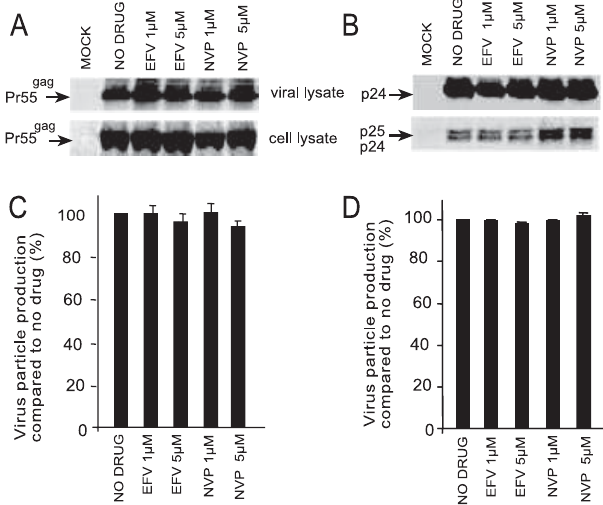
Figure 7. Inhibition of Viral Particle Production by EFV Is Dependent on a Functional HIV-1 PR and Is Mediated by the Drug Binding to p66 RT 293 T cells were transfected with (A) PR(-)pNL4.3 that contains an active site mutation in the HIV-1 PR or (B) K103NpNL4.3 that prevents EFV binding to RT. Cells were transfected and treated with Trans[ 35 S]-label as described in Figure 6. Top panels represent virion-associated Gag or p24 and bottom panels represent Gag or Gag processing products present in cell lysates. Quantitation of viral particle production in 293T cells transfected with (C) PR(-)pNL4.3 and (D) K103NpNL4.3. Data represent at least three independent experiments and are expressed as the mean 6 standard error.